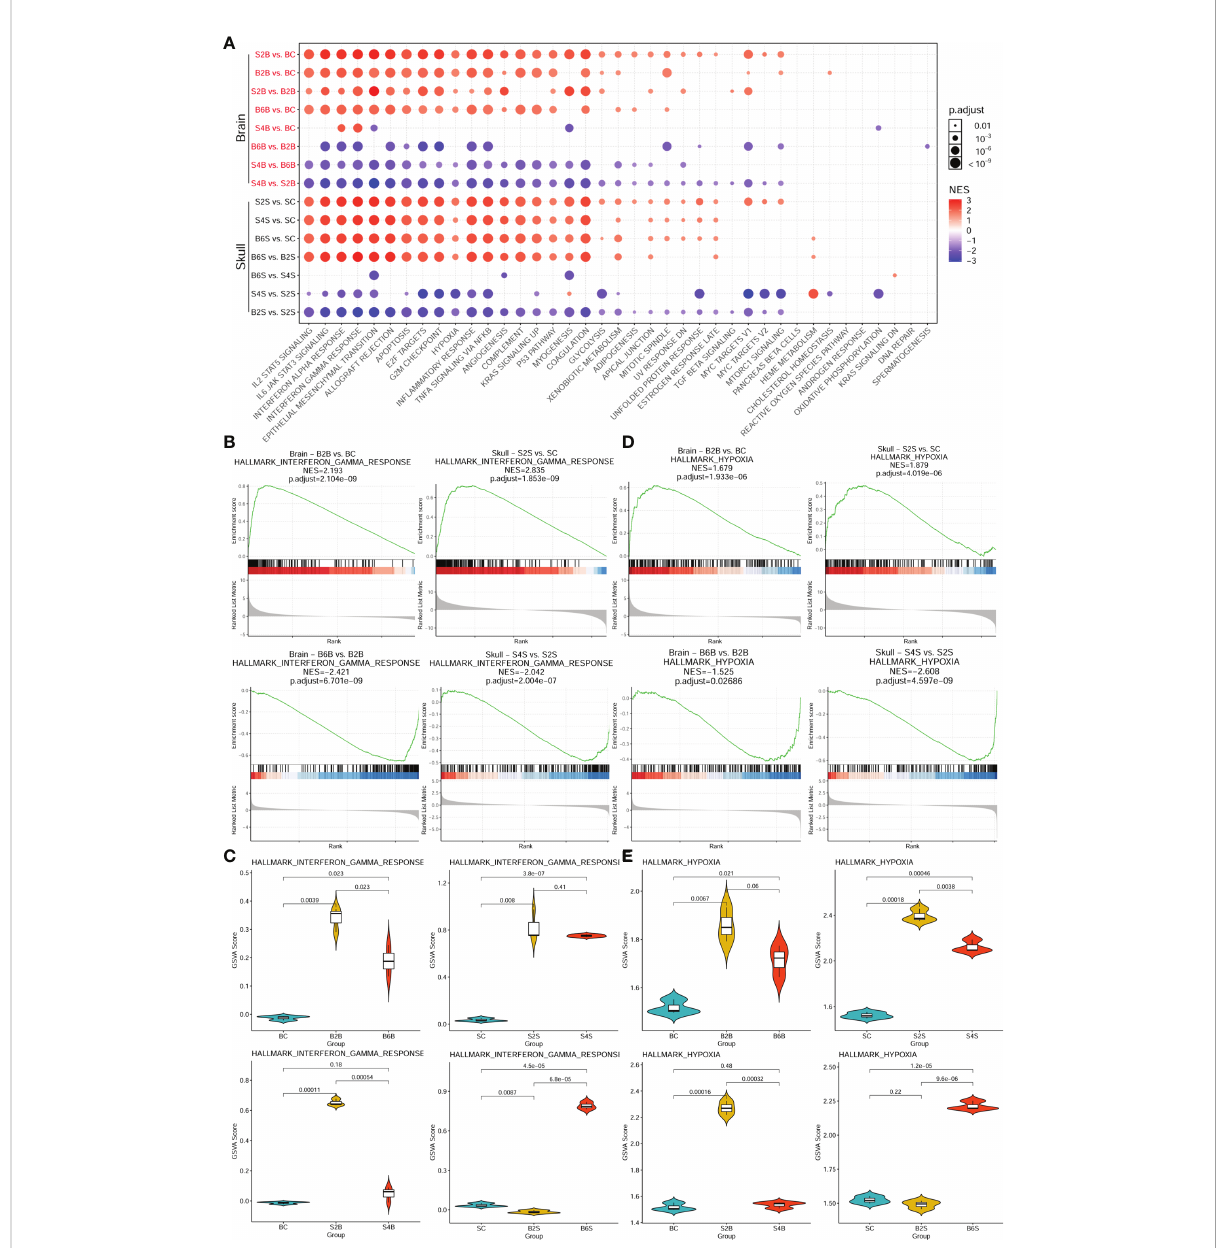
FIGURE 4 Enrichment analysis of the genes associated with the cancer hallmark pathways in brain and skull ischemic injury. (A) Enrichment patterns of the brain and skull ischemic injury-related genes in the cancer hallmark pathways. (B, D) Gene set enrichment analysis (GSEA) between the brain and skull ischemic injury groups for the representative interferon gamma response (B) and hypoxia (D) pathways. (C, E) Gene set variation analysis (GSVA) scores of the single samples for the representative interferon gamma response (C) and hypoxia (E) pathways ( n = 3). BC , control group for the uninjured brain; B2B and B6B , brain samples of the second and sixth days after brain photothrombosis (PT); SC , control group for the uninjured skull; S2S and S4S , skull samples of the second and fourth days after skull PT; B2S and B6S , skull samples of the second and sixth days after brain PT; S2B and S4B , brain samples of the second and fourth days after skull